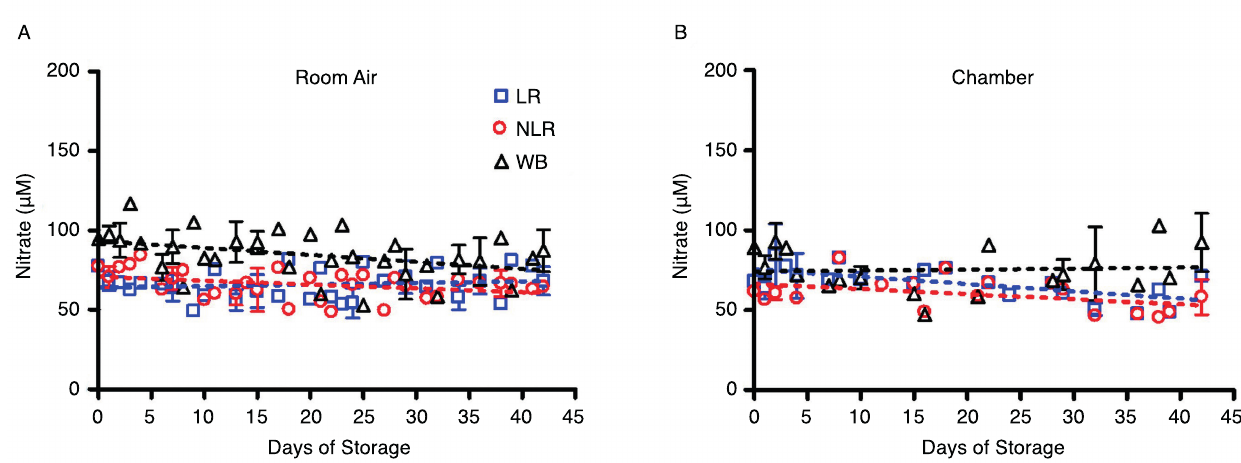
Figure 4. Effect of storage on nitrate concentration in blood stored for 42 days in room air (4A) or an argon chamber (4B); number of donors, n=3 (A), n=3 (B).